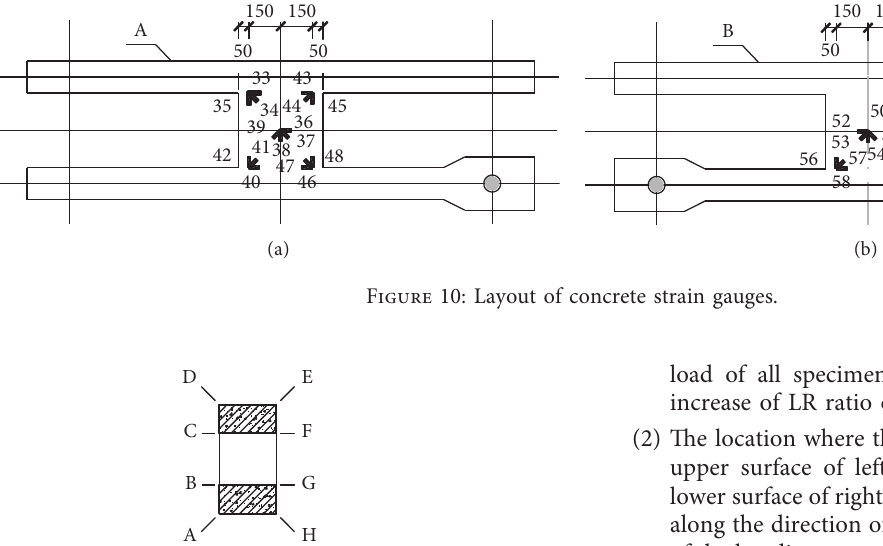
Figure 11: Number of longitudinal contour